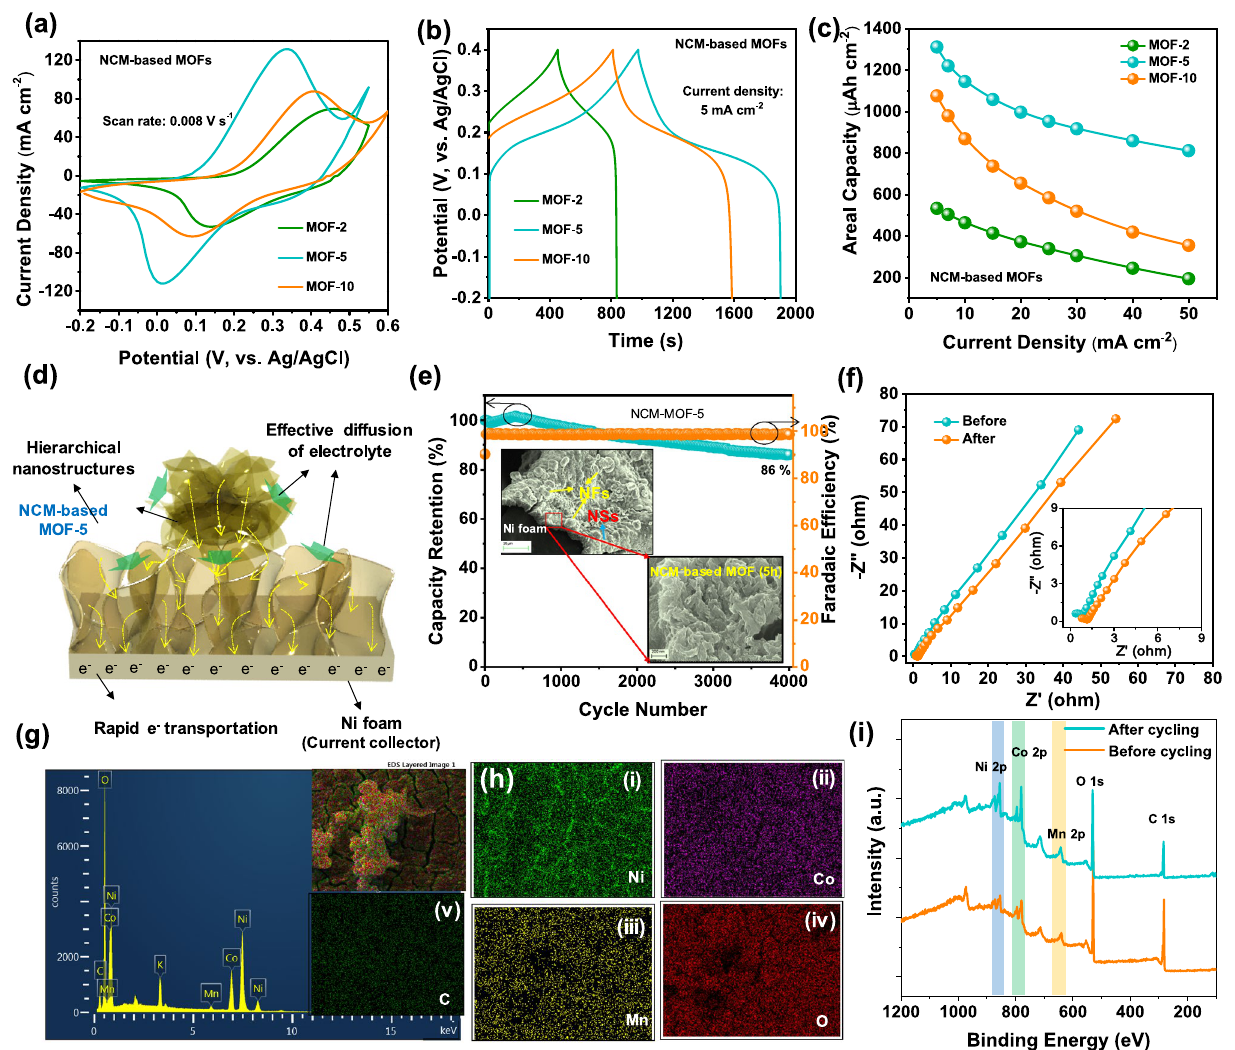
Fig. 5 Comparitive a CV curves evaluated at constant scan rate of 0.008 V s −1 , b GCD curves measured at a current density of 5 mA cm −2 , and c estimated capacity values of the NCM-based MOF-2, MOF-5, and MOF-10 electrodes, respectively. d Schematic illustration regarding the merits of the prepared electrodes during electrochemical measurements. e Cyling stability of the NCM-based MOF-5 electrode over 4000 charge–discharge cycles and f EIS plots of the NCM-based MOF-5 electrode before and after the cycling process. The inset of e shows the FE- SEM images of NCM-based MOF-5 after the cycling test. g EDX spectrum, h elemental mapping images, and i XPS survey scan spectra of NCM-based MOF-5 after the cycling test, which indicates that the respective elements still existed on the NCM-based MOF-5